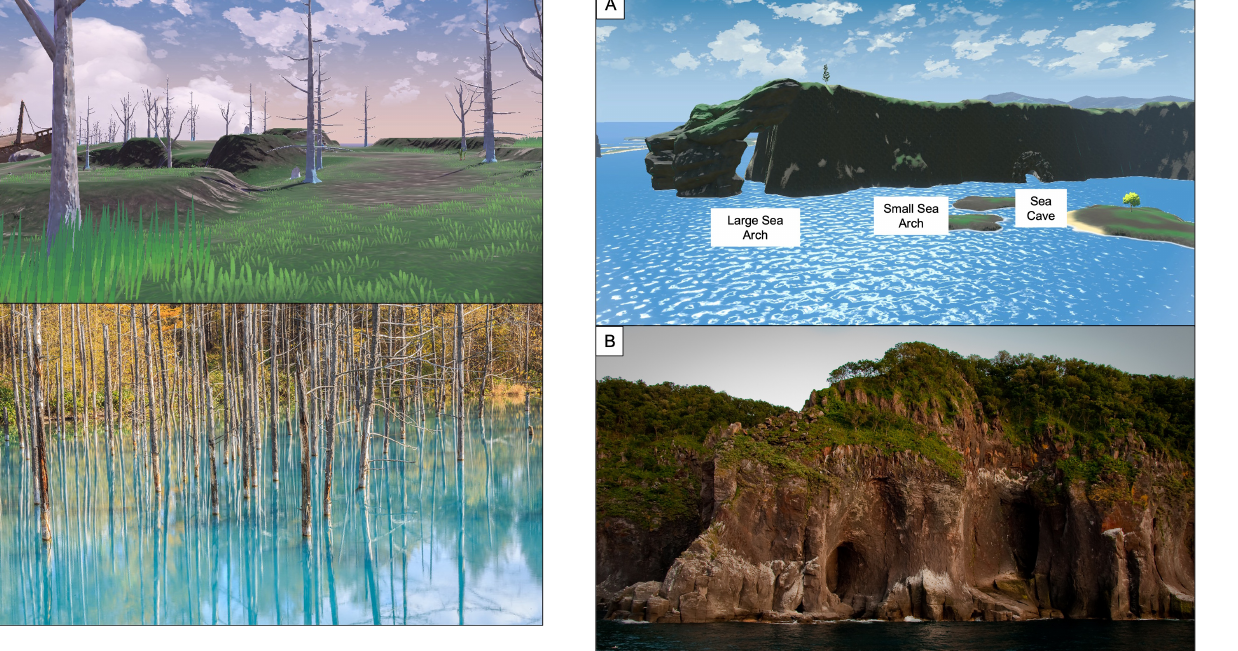
Figure 3. Comparison image of in-game and real-world inspiration. (a) White trees found in Deadwood Haunt, Cobalt Coastlands, in Pokémon Legends: Arceus (Fig. 1a1), ©The Pokémon Company In- ternational (2022a). (b) Photograph of dead larch trees, Blue Pond, central Hokkaido (Fig. 1b1) (Gilad Rom, 2015).